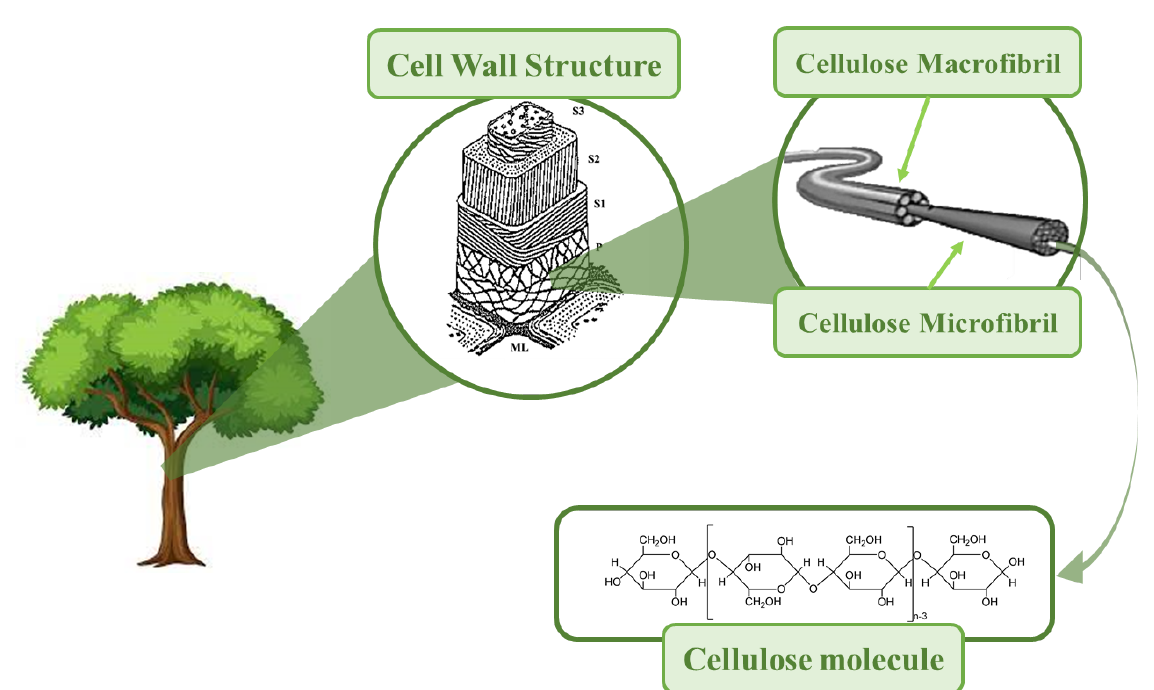
Figure 1. The simplified structural hierarchy of cellulose from a molecule to wood tissue.